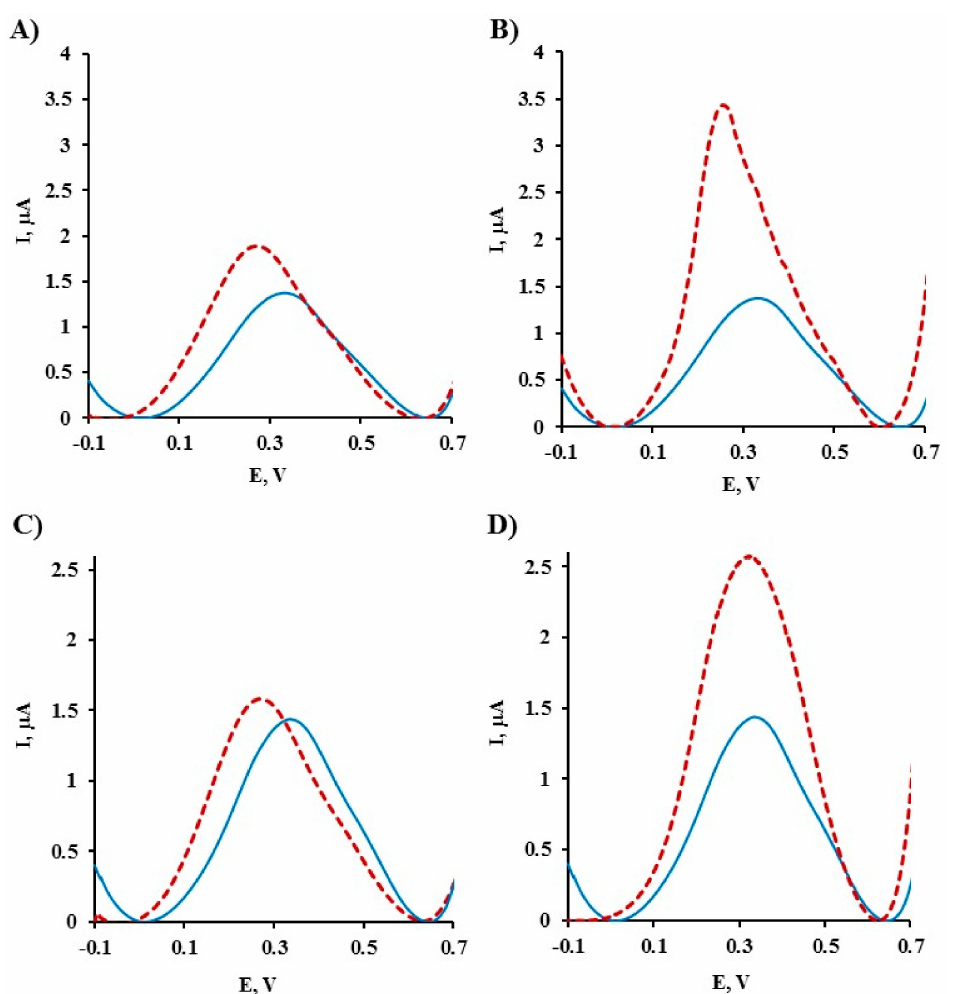
Figure 2. Representative Osteryoung square-wave voltammograms obtained for the gold electrode modified with: ( A ) TPY (solid line) and TPY / Co(II) (dashed line) ( B ) TPY (solid line) and TPY / Cu(II) (dashed line) ( C ) DPM (solid line) and DPM / Co(II) (dashed line) ( D ) DPM (solid line) and DPM / Cu(II) (dashed line) Bu ff er conditions: PBS pH